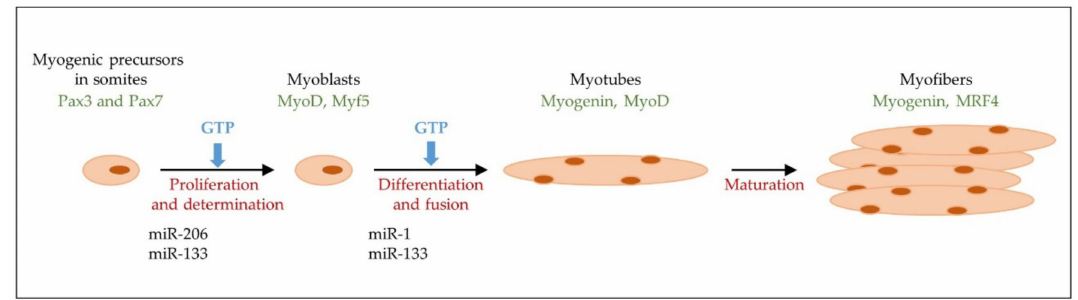
Figure 2. A schematic representation of myogenesis. The phases of myogenesis, main transcription factors, miRNAs and GTP involved in the development of the mature muscle fiber are